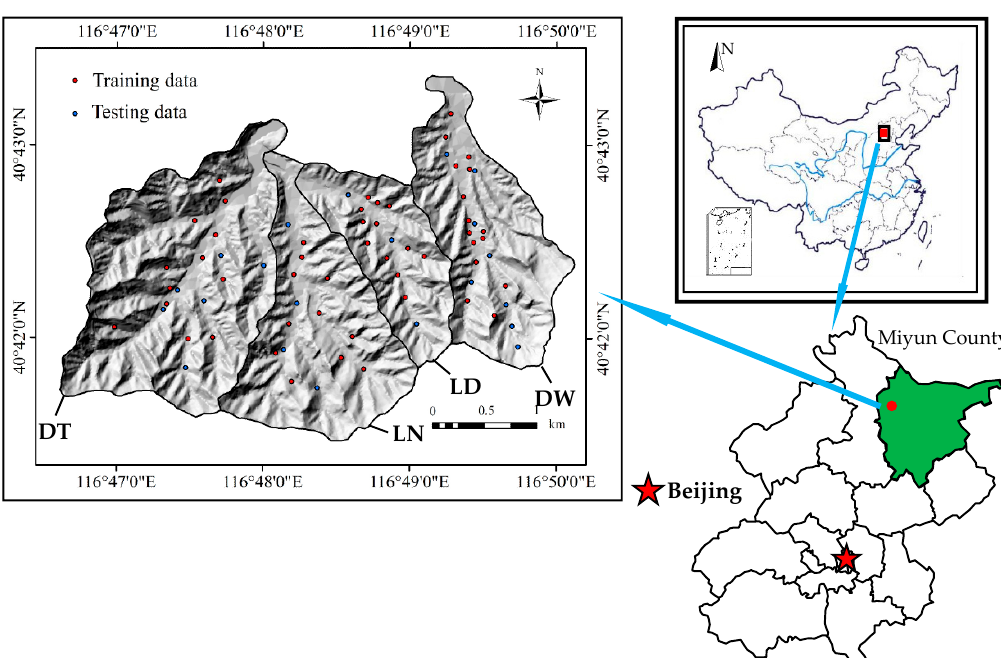
Figure 1. Geographical position of the study area. Note: DT = Duitaizi catchment; LN = Lamazhazi Nan catchment; LD = Lamazhazi Dong catchment; DW = Dawa catchment.